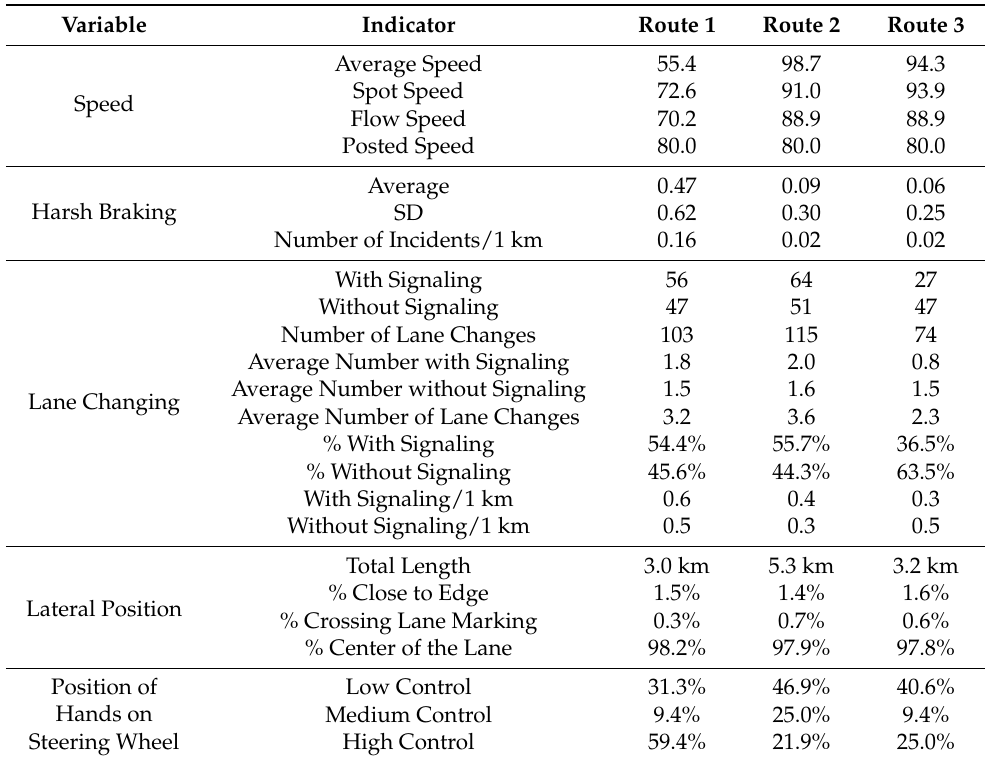
Table 5. Descriptive results of measured